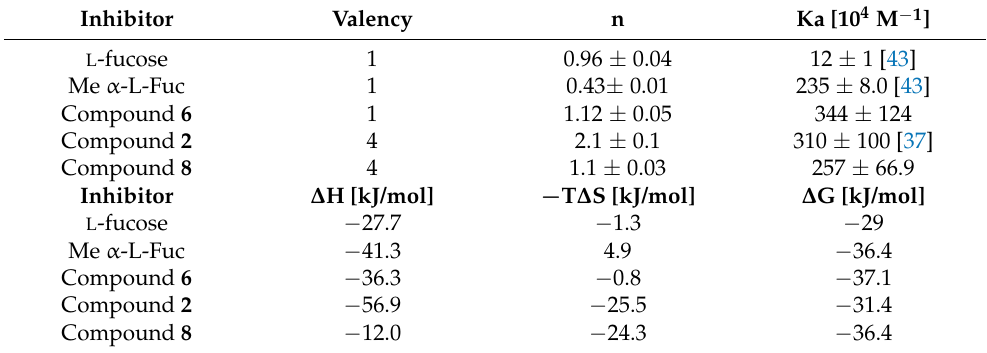
Table 2. Thermodynamic parameters of interactions between lectin PA-IIL and